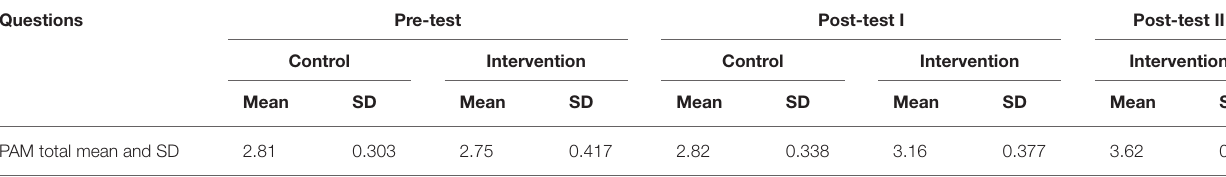
TABLE 2 | Descriptive summary of patient activation measurement